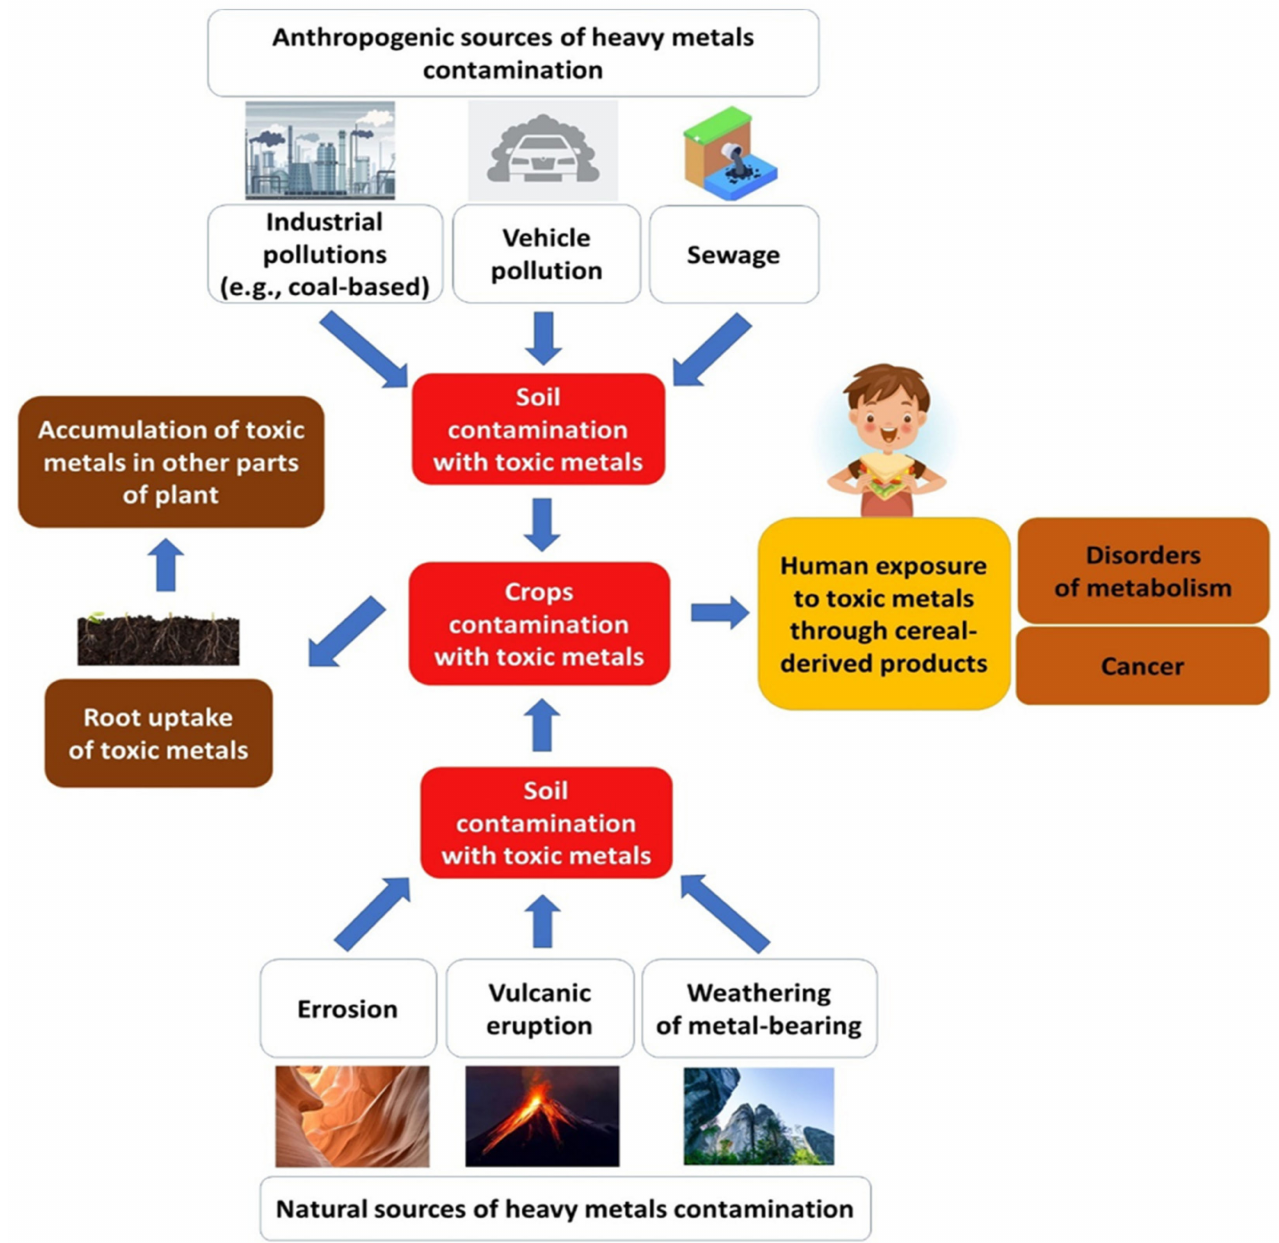
Figure 5. Natural and anthropogenic sources of heavy metal contamination in food crops and mechanisms of their uptake by plants, with the resulting adverse impacts on